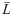
Results of pipette aspiration testing.(A) Experimental measurements from two pipette aspiration tests at the right ventricular location showing how strain energy density was calculated. The hearts from both tests are from the same litter. For the control heart, the area with diagonal cross-hatch represents the strain energy density (SED) calculated for L¯ = L/ri = 0.2; the strain energy density at L¯ = 0.4 is the sum of the diagonal cross-hatch and vertical cross-hatch areas. For the mutant heart, the shaded red area represents the SED calculated for L¯ = L/ri = 0.2; the strain energy density at L¯ = 0.4 is the sum of the red and blue shaded areas. (B) Mutant hearts developing persistent truncus arteriosus (PTA) had significantly stiffer left and right ventricular walls as measured by pipette aspiration. Mean SED for ED12.5 mouse is shown for ranges of L/ri = 0–0.2 and 0–0.4 (n = 10). Error bars: standard error. Symbols: * on the mutant SED indicates p<0.05 difference from the corresponding control, + indicates p<0.10 difference; # indicates p<0.05 difference between either control OFT or LV location and the RV location.